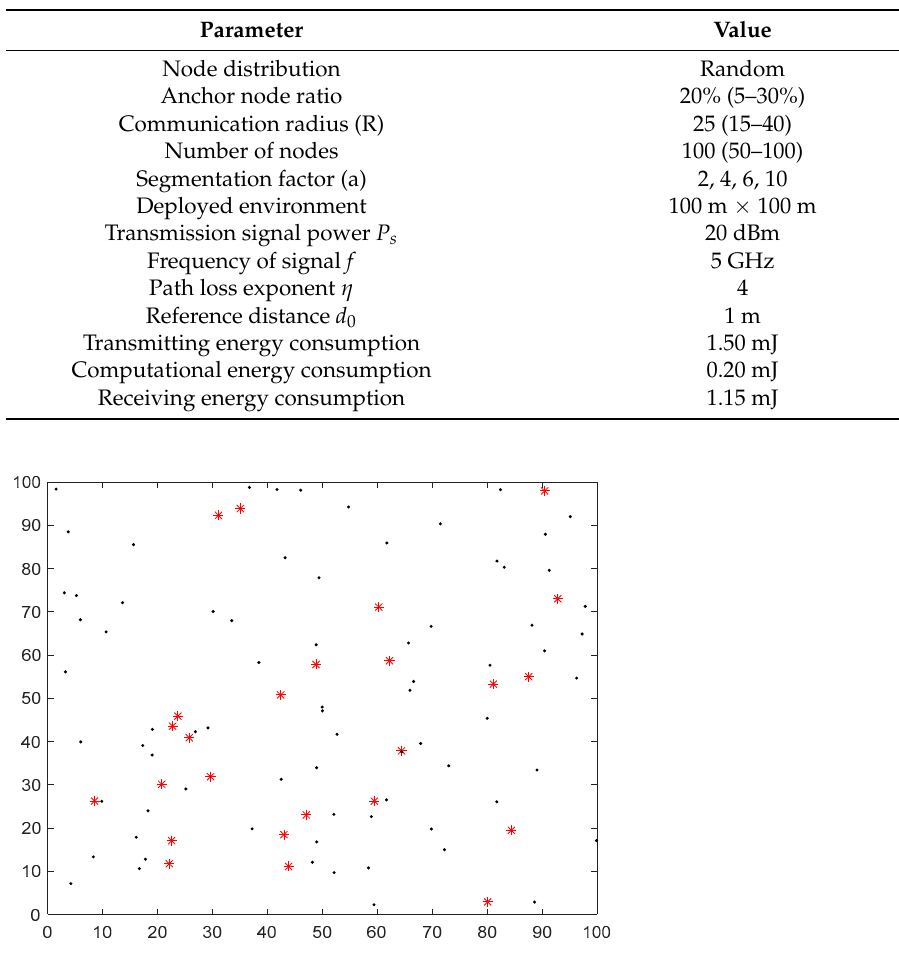
Figure 8. Schematic of random node deployment.